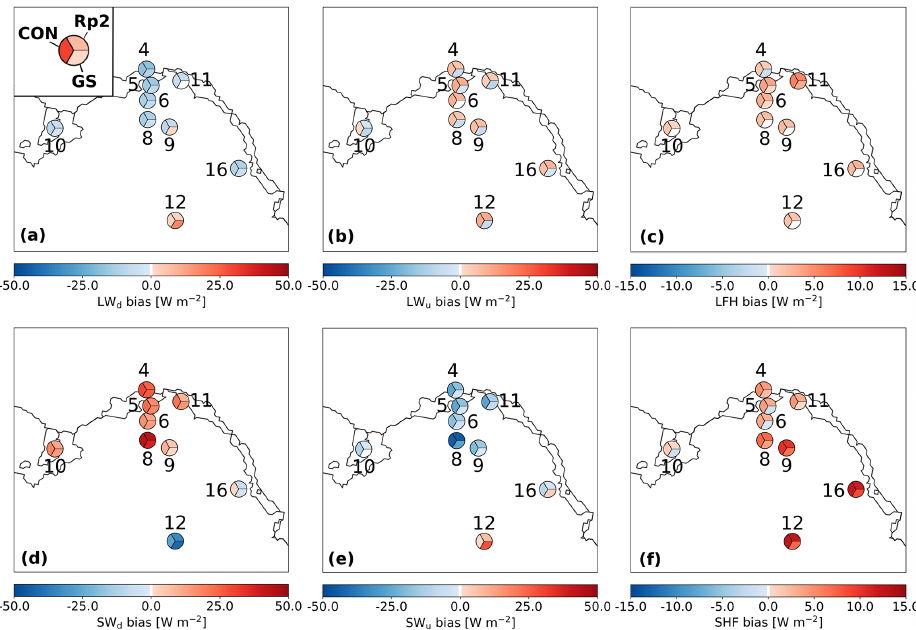
Figure 6. Bias of monthly-averaged downward and upward longwave and shortwave fluxes during summer (LW d , LW u , SW d , SW u , respec- tively), sensible heat flux (SHF), and latent heat flux (LHF) using AWS data of DML between 1997 and 2012. Each numbered circle chart represents an AWS (locations shown in Fig. 2b) and is split into three parts: the upper right shows the bias of Rp2 with observations, the lower right GS and the left CON.